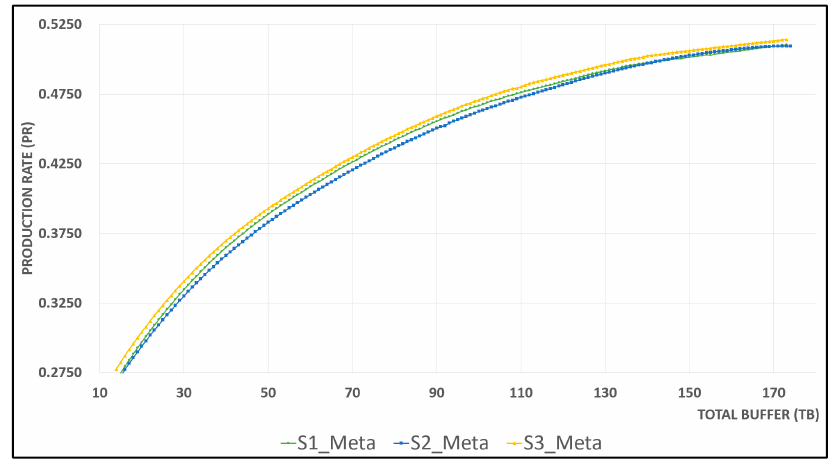
Figure 4. Behavior of production rate with total buffer (TB) and reconfiguration